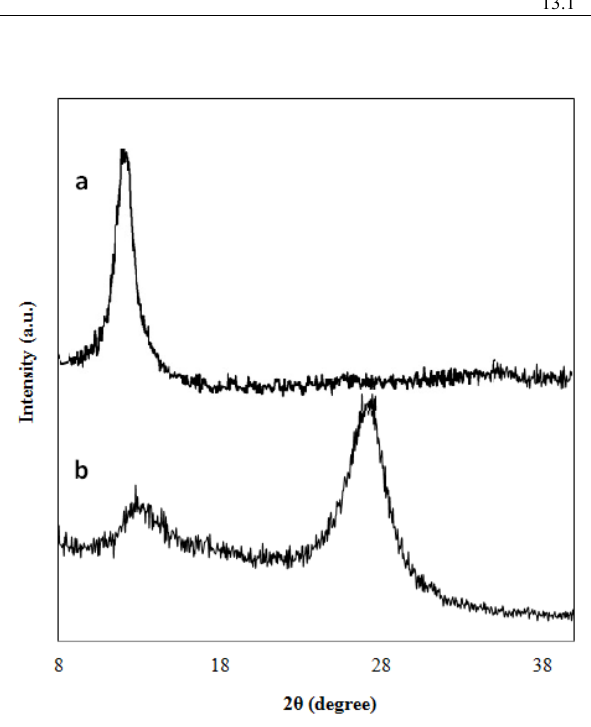
Fig. 1. XRD pattern of the prepared graphene oxide (a), and g-C